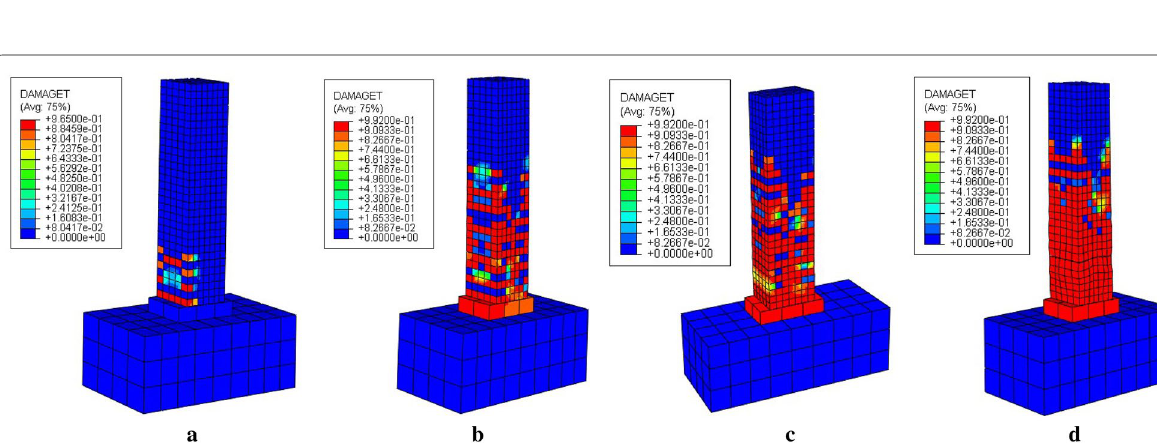
at the boundary levels between the PC parts and the postcast region.